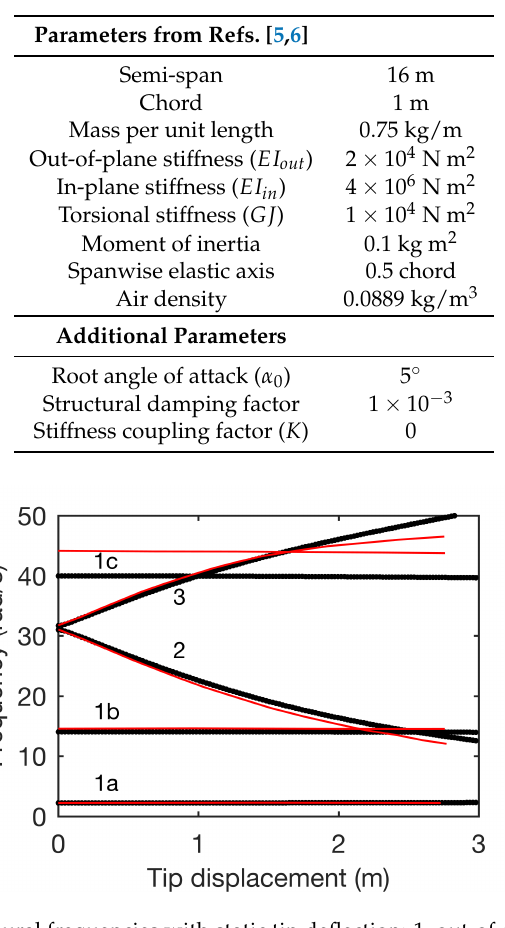
Figure 3. Variation of natural frequencies with static tip deflection: 1. out-of-plane, 2. torsion/in-plane and 3. in-plane/torsion (red from Ref.